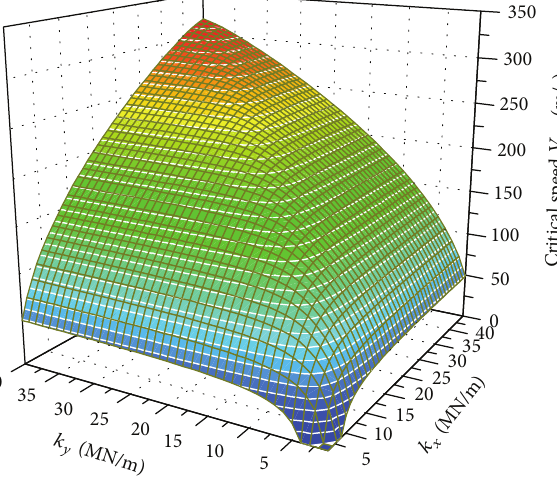
Figure 5: Gyroscopic contributory ratio.